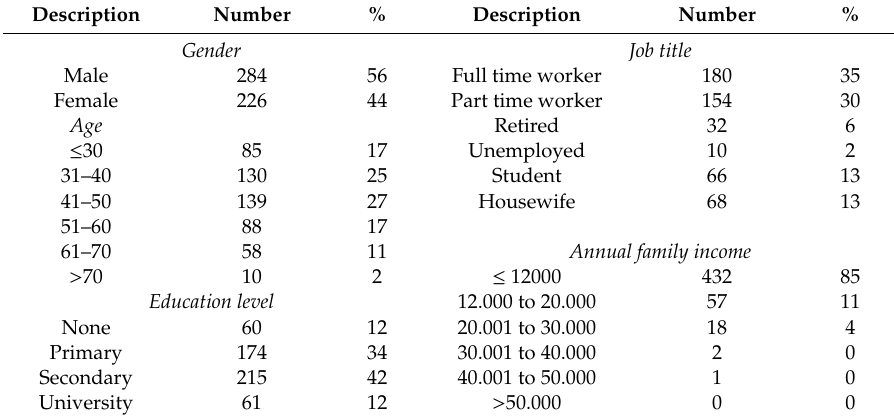
Table 8. General survey results.